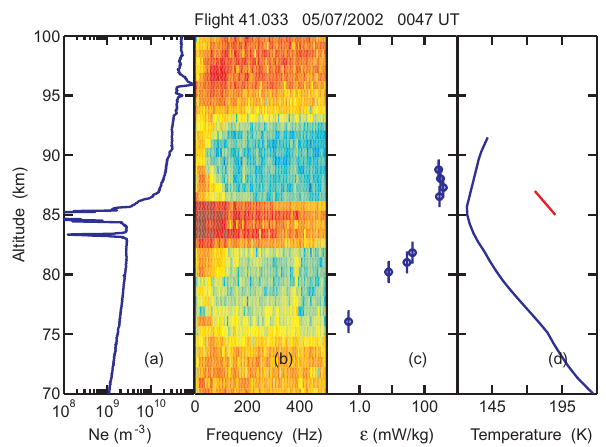
Fig. 2. Data obtained 5 July 2002, 00:47 UT (Flight 41.033) from Andøya, Norway. (a) : electron density; (b) negative charge irregu- larities; (c) , inferred energy dissipation rates; (d) , neutral tempera- ture measured by an adjacent falling sphere flight. The red line in (d) indicates the slope of the adiabatic lapse